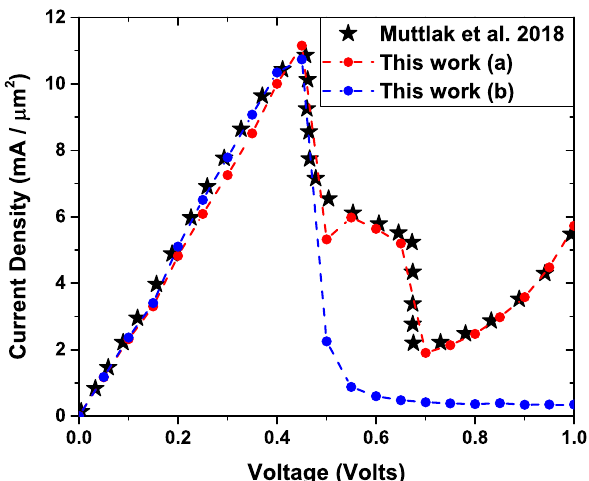
Figure 12. Comparison between simulated results using Equation (13) (red and blue dots) and experimental results [54] (black